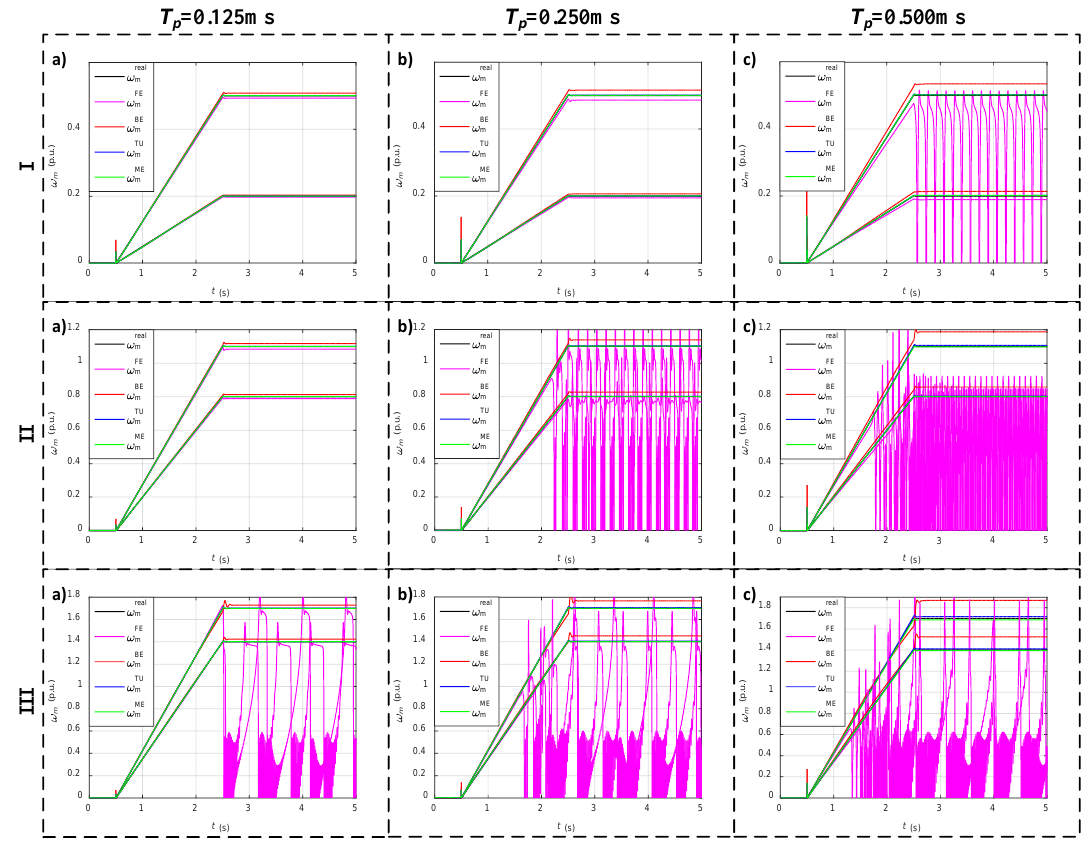
Figure 6. Speed estimation after MRAS CC discretization using four numerical integration methods for three di ff erent sampling steps: column ( a ) T p = 0.125 ms, column ( b ) T p = 0.250 ms, column ( c ) T p = 0.500 ms. Row I— ω m = {0.2 and 0.5} p.u., row II— ω m = {0.8 and 1.1} p.u., row III— ω m = {1.4 and 1.7} p.u.